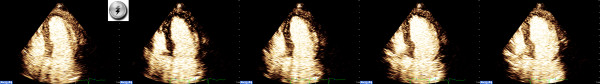
Flash replenishment sequence. Assessment of myocardial perfusion after dipyridamole. From left to right: uniform transmural perfusion seen in apical 4-chamber before flash, then images taken 1, 3, 4 and 8 cardiac cycles after microbubbles destruction. Perfusion defects become apparent after flashing (flash icon in the figure) both in the anterior descending and circumflex coronary arteries perfusion territories, still detectable after 8 cycles; the patient had no clear WM abnormality, even if mild tardokinesia of the septum was suspected. Angiography confirmed obstructive two-vessel disease with both stenosis ranging between 50% and 70%. Abbreviations as defined in table 1.